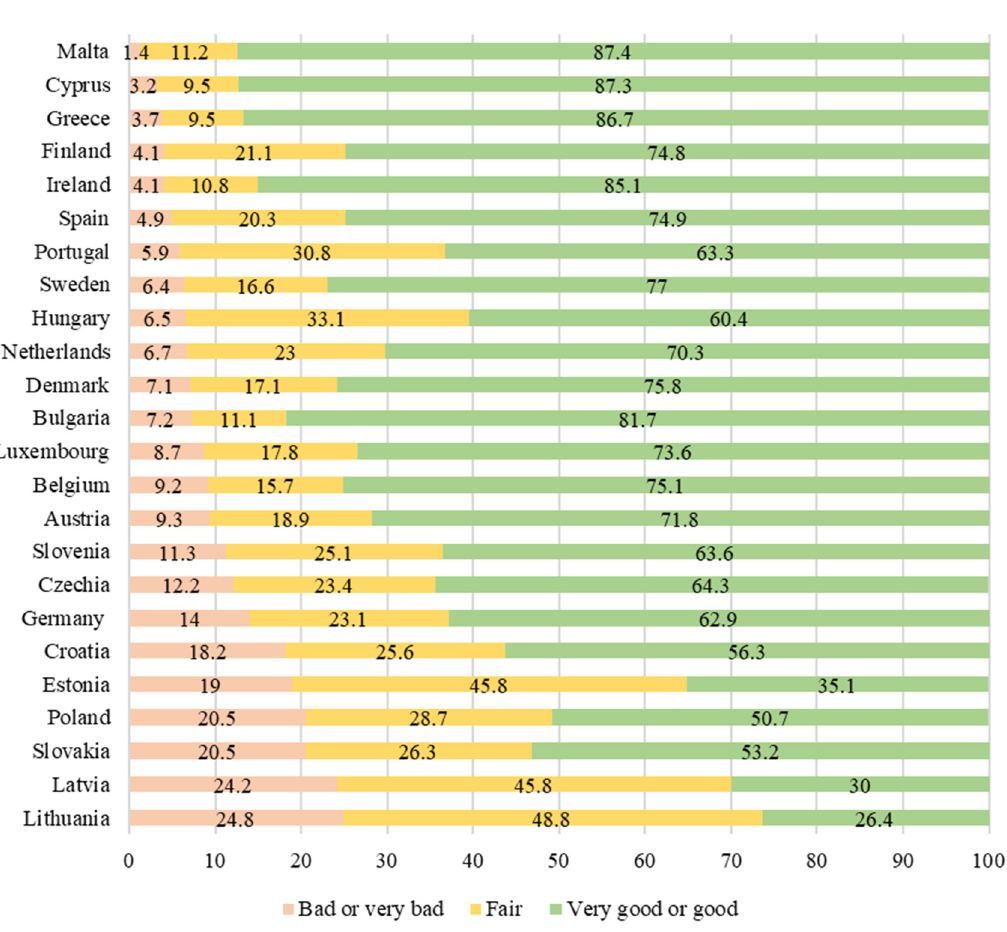
Figure 1. Self-perceived health, foreign population in European Union countries (EU28), 2020 (%). Source: Eurostat—last data extracted on 5 December 2021 (online data code: HLTH_SILC_23).